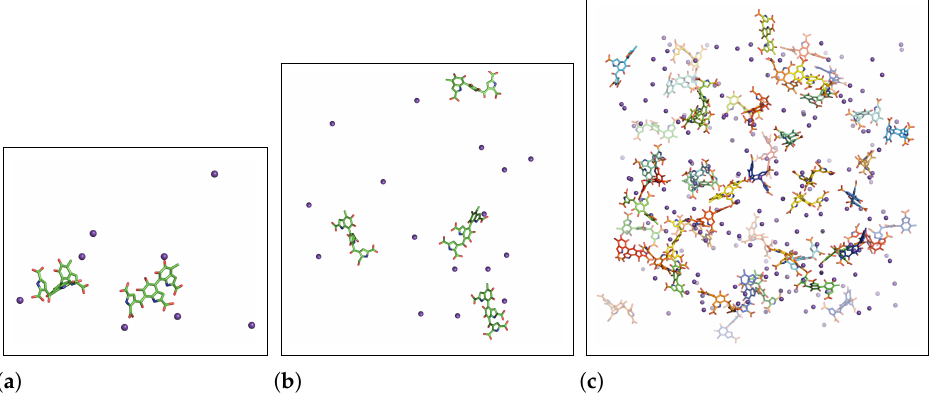
Figure 5. Aggregation of charged DHICA eumelanin molecules. Water molecules are not shown for clarity. Colours in ( a , b ): blue: nitrogen, red: oxygen, white: hydrogen, green: carbon. The potassium ions are shown in purple. ( a ) Two charged DHICA eumelanins after 1000ns, ( b ) four charged DHICA eumelanins after 1100ns, and ( c ) 50 charged DHICA eumelanins after 1361ns. In ( c ). rainbow colouring is used to distinguish the